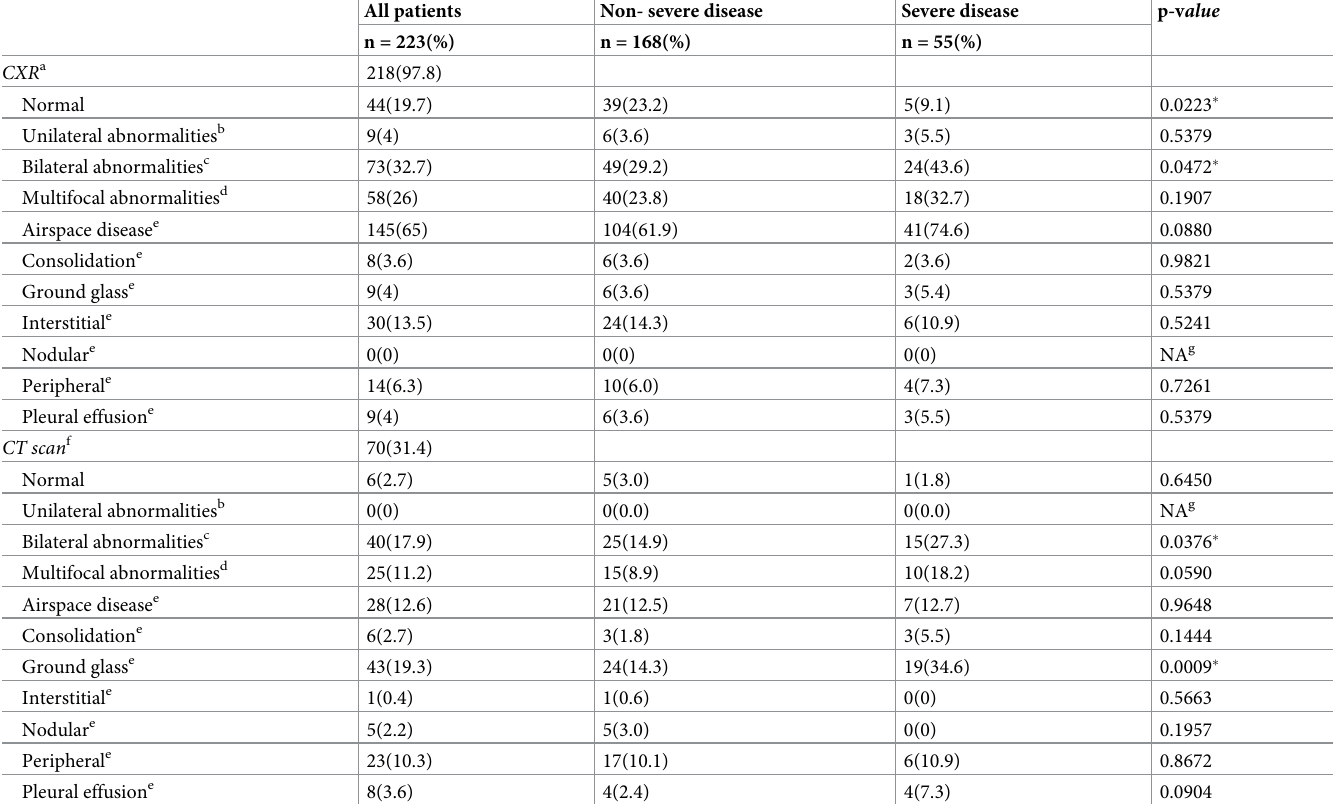
Table 7. Radiology imaging results during the first 24 hours of